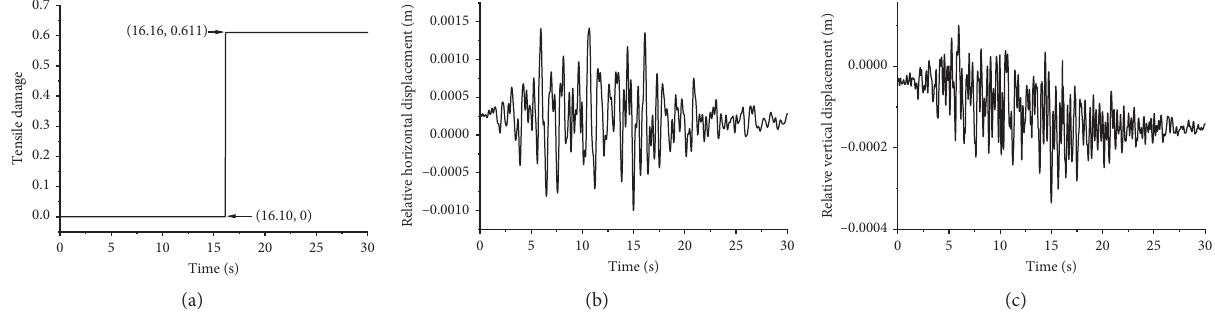
Figure 12: Time histories of relevant variables at the element 3400 for the earthquake overload coefficient of 1.53. (a) Time history of tensile damage variables. (b) The relative horizontal displacement is 0.28mm after the earthquake. (c) The relative vertical displacement is 0.14mm after the